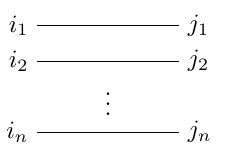
Figure 7 . The state | IJ i represents a configuration of n open strings with Chan-Paton factors ( i 1 , j 1 ) . . . ( i n , j n )